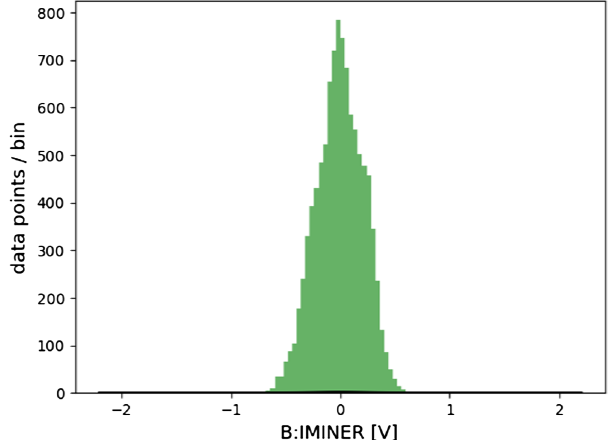
FIG. 3. Distribution of fractional measured error in the GMPS current at the minimum value of the magnet current, with the non- ML PID regulator discussed in the